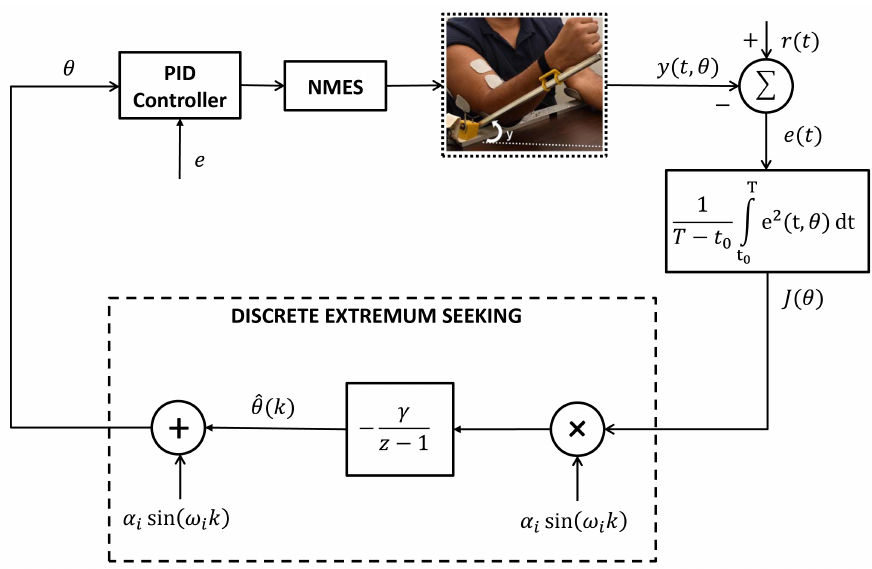
Figure 4 - Block diagram of the closed-loop system for NMES using deterministic discrete-time ES, where α i sin ( ω i k ) is the perturbation vector.